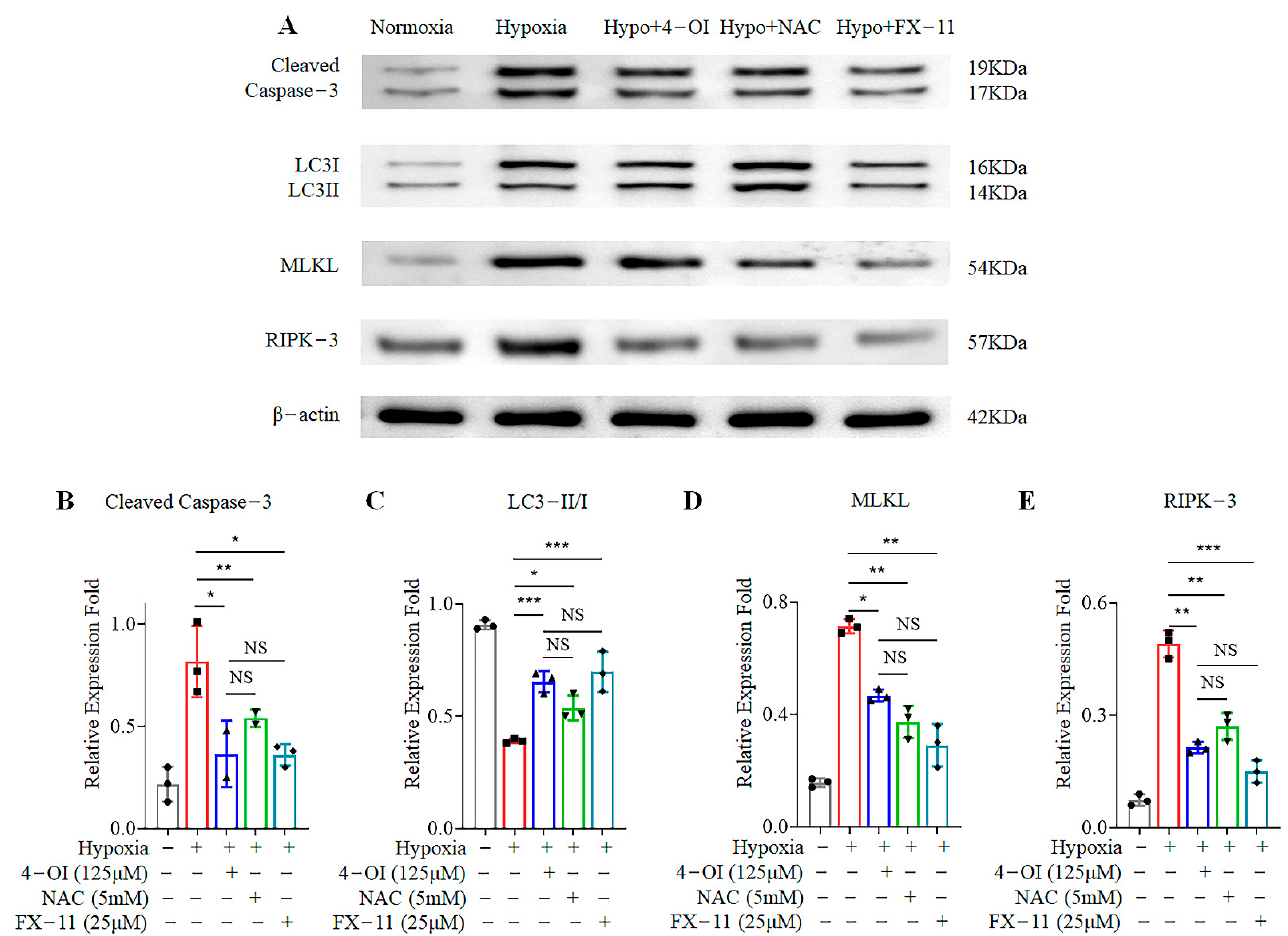
Figure 4. Treatment with 4-OI limits the activation of cell death pathways in MIN6 cells under oxi- dative stress: ( A ) The expression of key cell-death-related proteins in MIN6 cells with 4-OI or NAC or FX-11 treatments was determined by Western blotting. ( B – E ) The quantified graphs of the gray scale of the proteins in Western blots. Error bars represent the mean ± SD. One-way ANOVA was performed with * p < 0.05, ** p < 0.005, *** p < 0.0005, NS: non-significant.